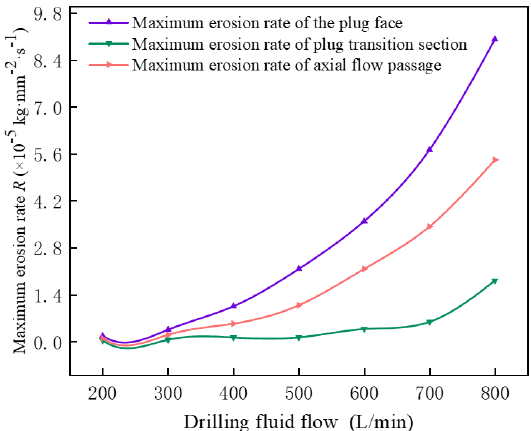
Figure 5. The maximum erosion rate changes with drilling fluid flow.